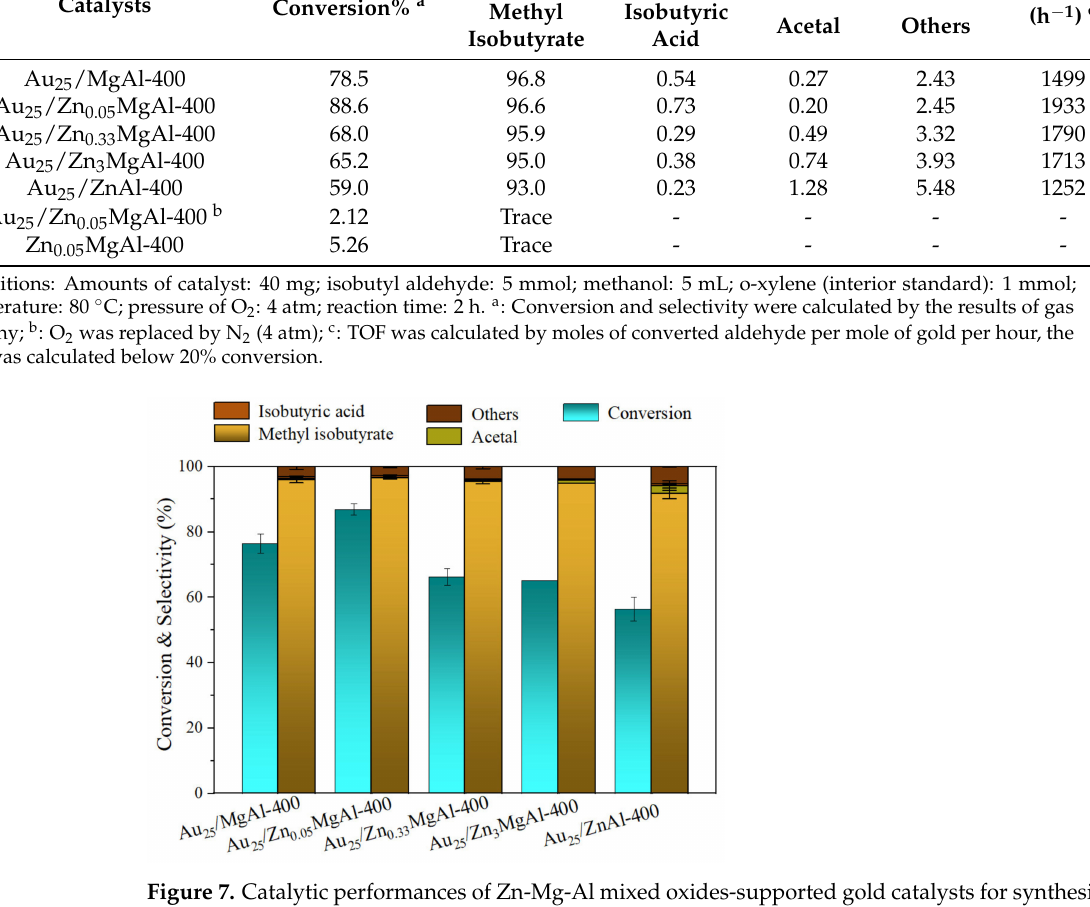
Figure 7. Catalytic performances of Zn-Mg-Al mixed oxides-supported gold catalysts for synthesis of methyl isobutyrate with error bar. Reaction conditions: catalyst: 40 mg; isobutyl aldehyde: 5 mmol; methanol: 5 mL; reaction temperature: 80 ◦ C; pressure of O 2 : 4 atm; reaction time: 2